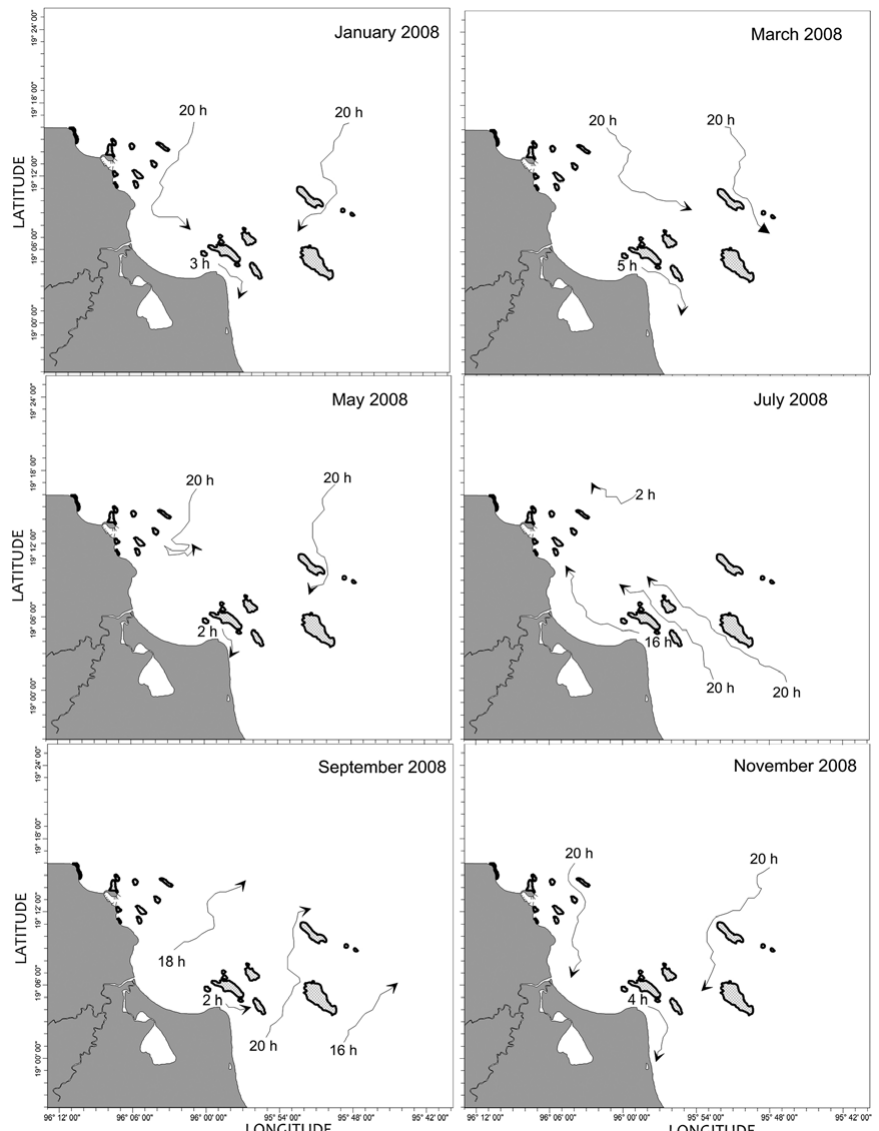
Fig. 3. – Surface (1 m depth) drift buoy trajectories and amount of time between their release and collection on 18 January, 21 March, 16 May, 18 July, 19 September and 21 November the summer (Fig. 2) with some variation (east-west) ow- is 45 m, whereas the depth of the northern reef area is ing to wind velocities. Since most of the coral spawning only 25 m. As observed with the surface current patterns takes place during the summer, it was suggested that the (Fig. 2), the flow rectified its trajectory near the reefs be- southern coral reef areas should be one of the sources of cause of topographic constriction, as observed using the coral larvae in the western Gulf of Mexico (Salas-Pérez objective analysis process performed with a triangular and Granados-Barba 2008). During northeasterly wind interpolation method with linear interpolations (Salas- conditions, the water flow accelerated at the constriction de-Leon et al. 2004a, b). Current rectification was also between the two reef areas and between the continu- observed with the drift buoys (Fig. 3), which rectified ous reefs because the same amount of water has to pass their trajectories near the reefs, moving parallel to the through a smaller area. Current velocities observed in reefs regardless of the wind velocity and season of the the southern reef area were higher than those observed in year. The drift buoys showed a dominant southward cur- the northern area, a result that was not expected based on rent component from November to May 2008, and the continuity, which would suggest an acceleration of the current reversed during the summer. The reversal of the flow due to the shallowness of the northern reef area and currents is mostly attributed to the Gyre of Campeche the proximity between reefs (Fig. 1). In this study the dif- and to remote winds, a mesoscale behaviour that affects ferences in velocities of the two reef areas was attributed the western Gulf of Mexico (Zavala-Hidalgo et al 2003, to bottom friction. The depth of the southern reef area Dubranna et al. 2011, Salas-Pérez et al. 2012, Allende-